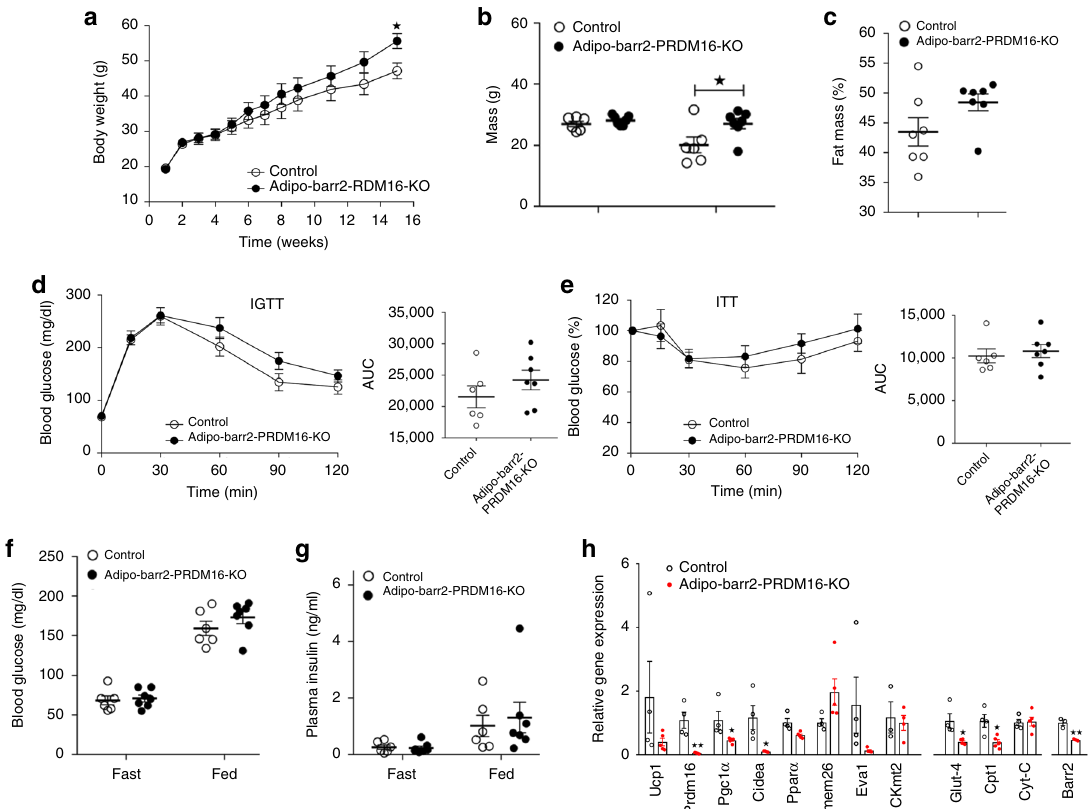
Fig. 6 The bene fi cial metabolic effects displayed by adipo-barr2-KO mice are absent in barr2-PRDM16 double KO mice. a Body weights of control mice (genotype: barr2 f/f Prdm16 f/f ) and adipo-barr2-PRDM16 double KO mice (genotype: adipoq-Cre barr2 f/f Prdm16 f/f ) maintained on a HFD after 4 weeks of age ( n = 6 or 7 per group). b , c Body composition ( b ) and fat mass (% of body weight) ( c ) of the indicated mouse strains maintained on a HFD for 15 weeks. d , e IGTT (1 g glucose/kg i.p) ( d ) and ITT (0.75 U insulin /kg i.p.) ( e ). Mice were maintained on a HFD for 8 – 9 weeks ( n = 6 or 7 per group). AUC, area under the curve. f , g Freely fed and fasting blood glucose ( f ) and plasma insulin levels ( g ) in mice maintained on a HFD for 10 weeks ( n = 6 or 7 per group). h Relative transcript levels of browning/beiging marker genes and other key metabolic genes, including barr2 , determined by qRT-PCR analysis of iWAT RNA after 16 weeks of HFD feeding ( n = 4 per group). Male mice were used for all studies. Data are expressed as means ± s.e.m. * p < 0.05, ** p < 0.01 ( a two-way ANOVA followed by Bonferroni ’ s post hoc test; b , c , f – h two-tailed Student ’ s t